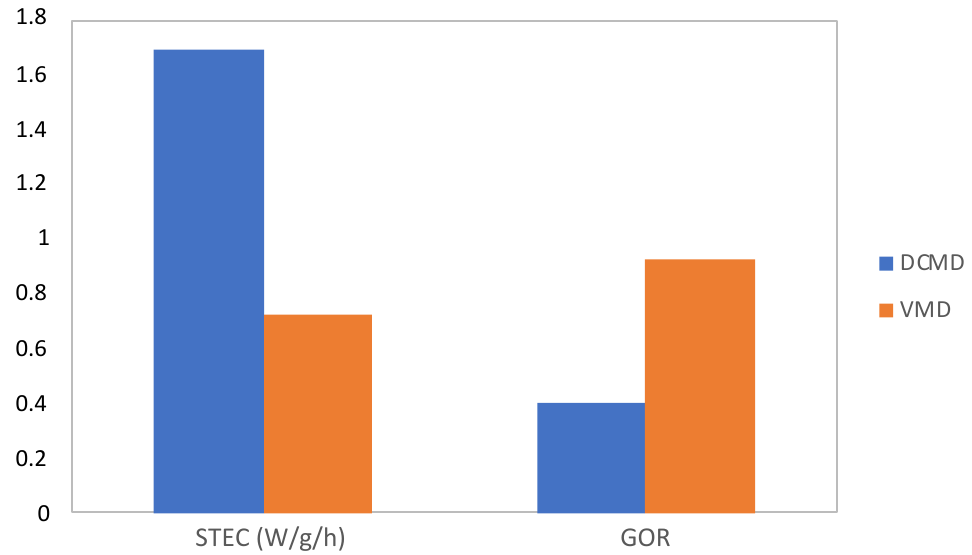
Figure 7. STEC and GOR of the two MD units, considering for both the experimental feed temperature decay of the VMD unit (0.2 °C).